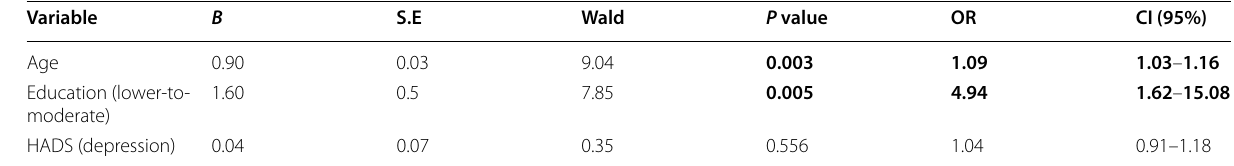
Bold text indicates statistical significance, where 95% confidence intervals do not include null value